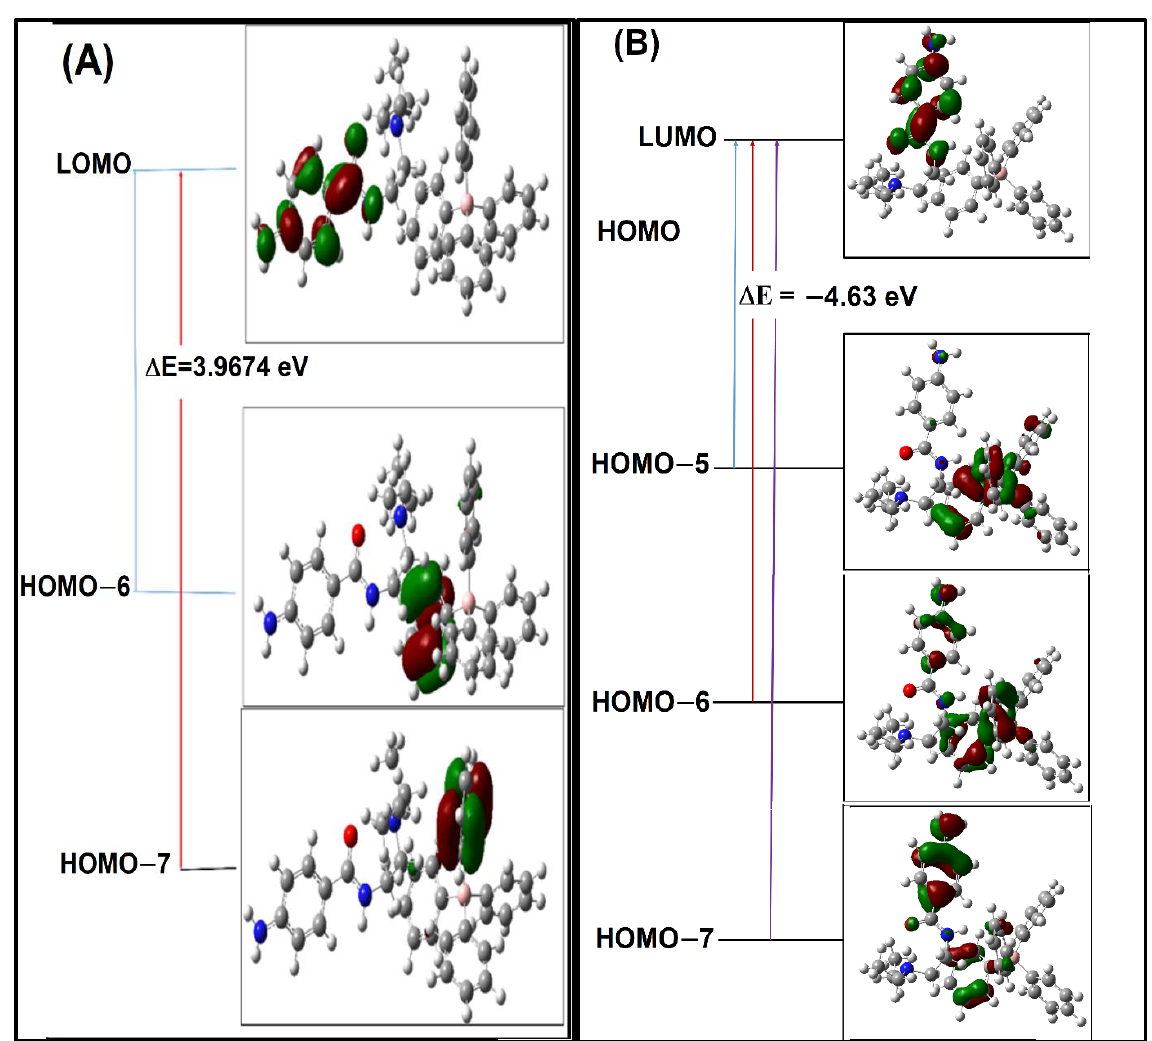
Figure 4. Electronic absorption in the gas phase is facilitated by band gaps (ΔE) and frontier molecular orbitals in both ( A ) complex S1 and ( B ) complex S2 (E).